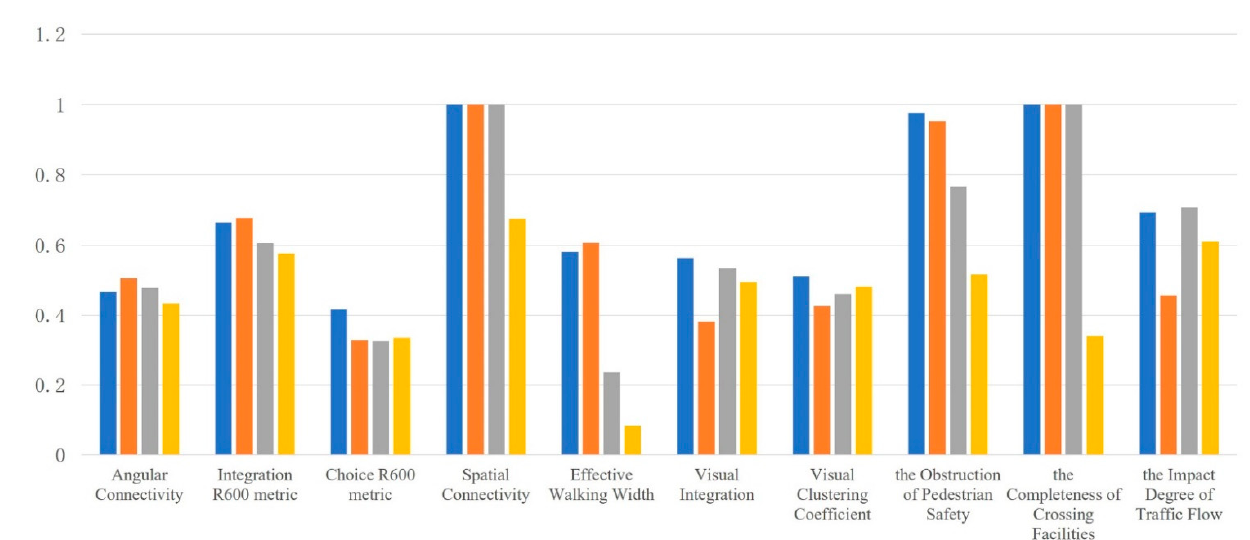
Figure 16. Comparative analysis of the mean values of spatial characteristics of various impact factors in the four types of roads.